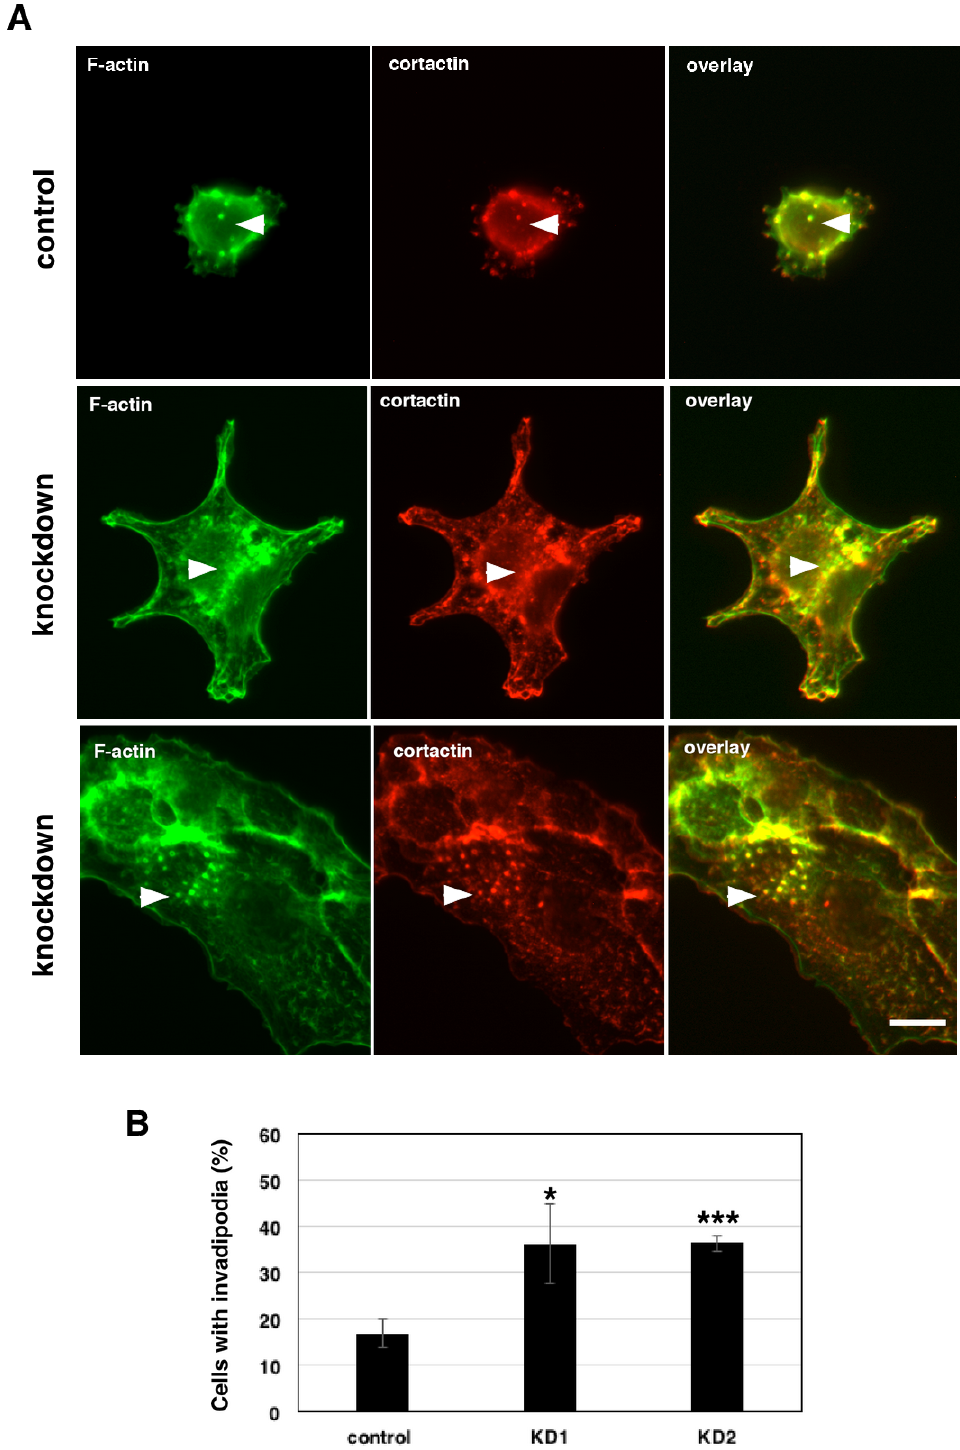
Figure 7. mGBP-2 inhibits invadopodia formation. Cells plated on coverslips and allowed to adhere overnight, were treated with 1 μ M PDBu for 30 min, fixed, and stained for cortactin, actin, and DAPI as described in Materials and Methods. ( A ) Images of invadipodia in the cell lines. ( B ) The percent- age of cells containing invadipodia were determined for each cell type and represented as the mean ± SD (*, p < 0.05; ***, p < 0.001 compared to control cells; n = 3). Size bar = 10 μ m. Together these data demonstrate that mGBP-2 acts to improve breast cancer progno- sis by inhibiting migration and the assembly of intracellular structures needed for inva- sion.